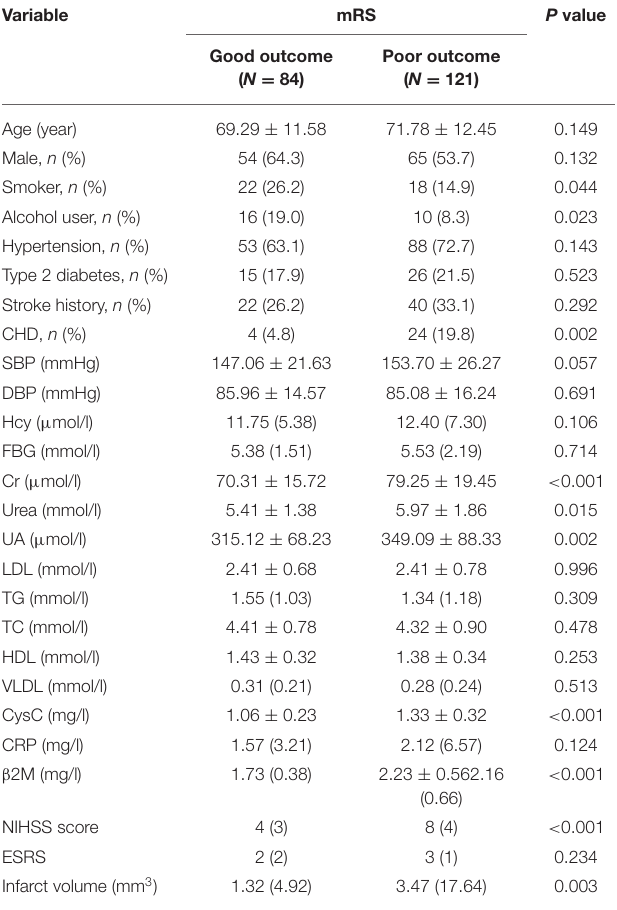
TABLE 1 | Clinical and laboratory findings in patients with good and poor 3-month outcomes. Variable